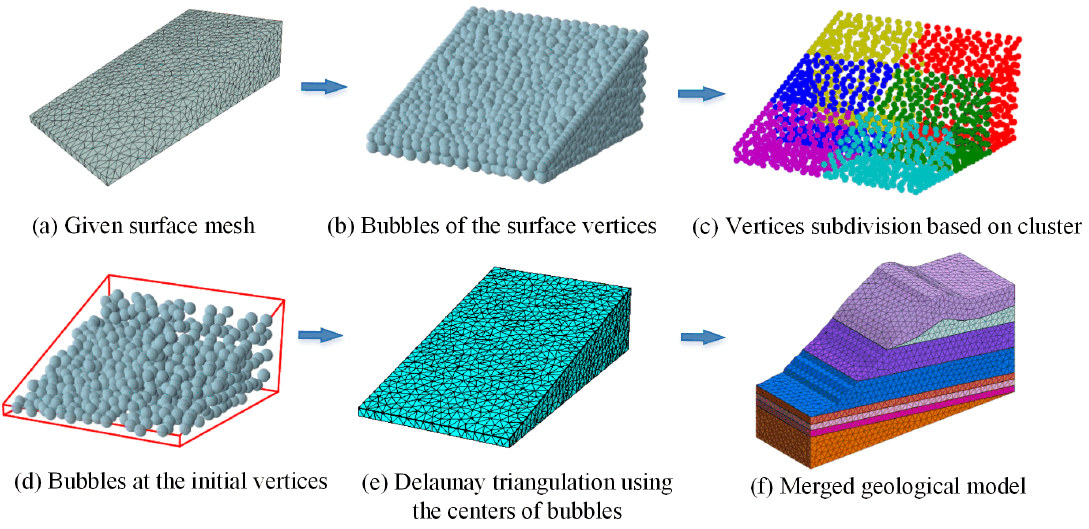
Figure 5. Procedure of the clustering-based bubble method for a three-dimensional